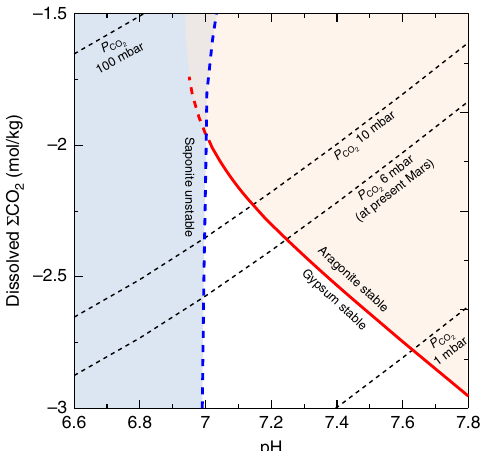
Fig. 3 Constrained pH- Σ CO 2 conditions (white area) in the pore water for mean water composition of the full-interaction scenario (Cumberland). The red line shows the stability boundary between carbonate and gypsum. The orange and sky-blue areas correspond to aragonite stable conditions and saponite unstable conditions, respectively. The broken lines show Σ CO 2 concentrations for P assuming dissolution equilibrium. See Methods for CO 2 calculation methodology